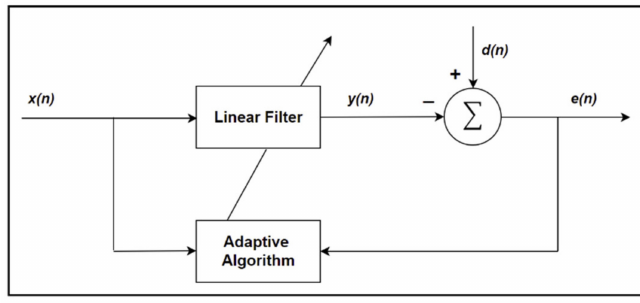
Figure 9. Scheme of a generic adaptive filter.